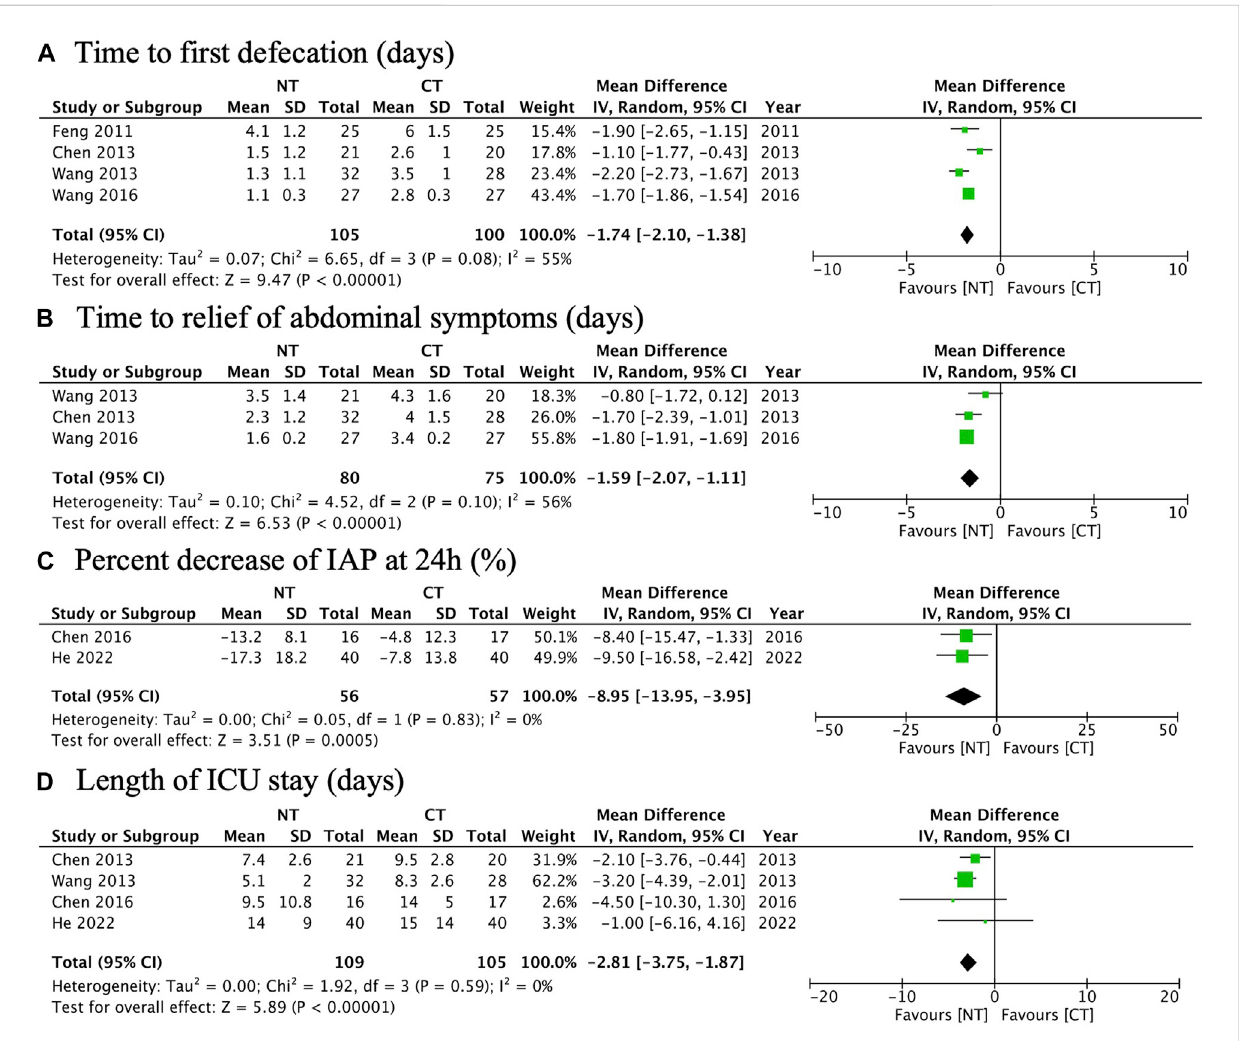
FIGURE 3 Forest plots illustrating the main outcomes (the primary outcome and some secondary outcomes): (A) time to the fi rst defecation; (B) time to the relief of abdominal symptoms; (C) percentage decrease of IAP at 24 h; (D) length of ICU